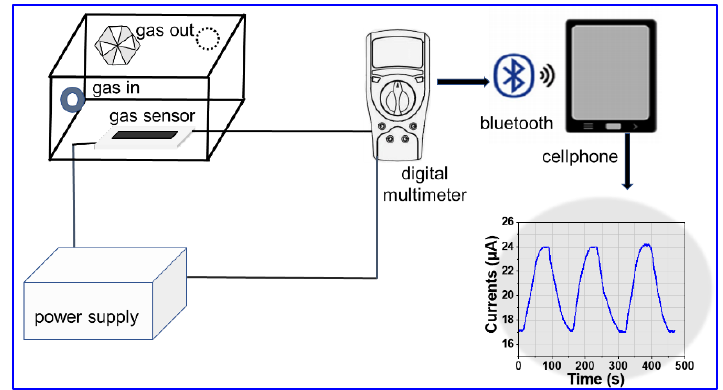
Figure 10. Measurement system for testing gas sensors.